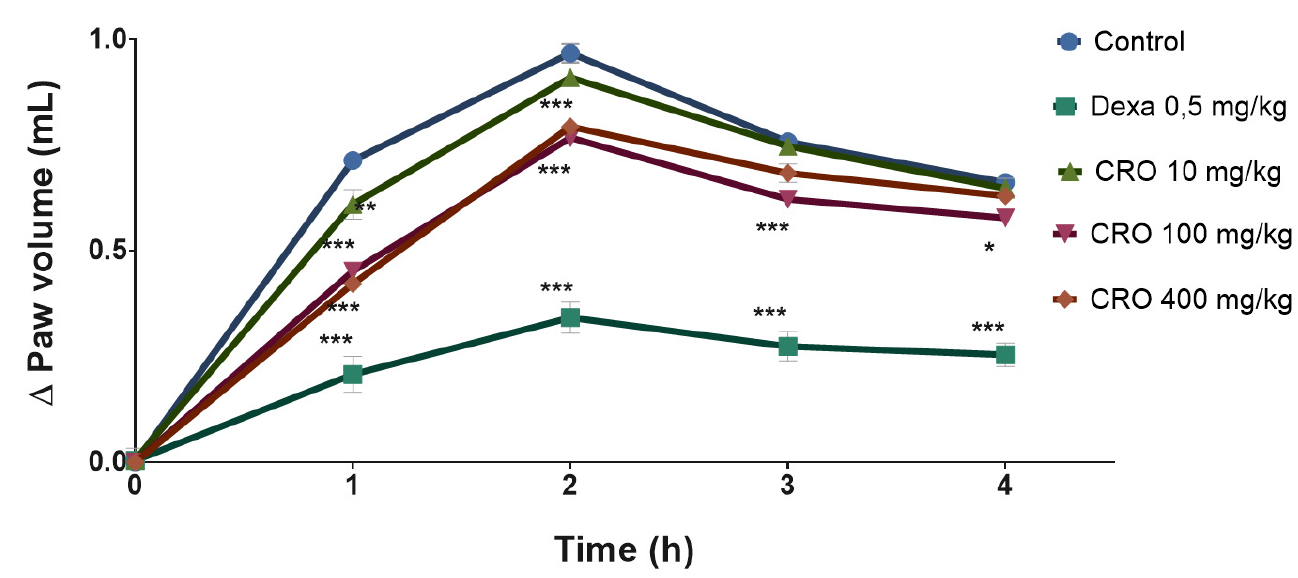
Figure 1. Effect of C. reticulata oleoresin (10, 100, and 400 mg/kg) and dexamethasone (0.6 mg/kg) administered orally to Wistar rats on the edematogenic stimulus induced by 1% carrageenan (200 µL, intraplantar). Each point represents the mean ± SE of a group of 5 animals. * p < 0.05; ** p < 0.01; *** p < 0.001 compared to control; two-way ANOVA, Bonferroni test.